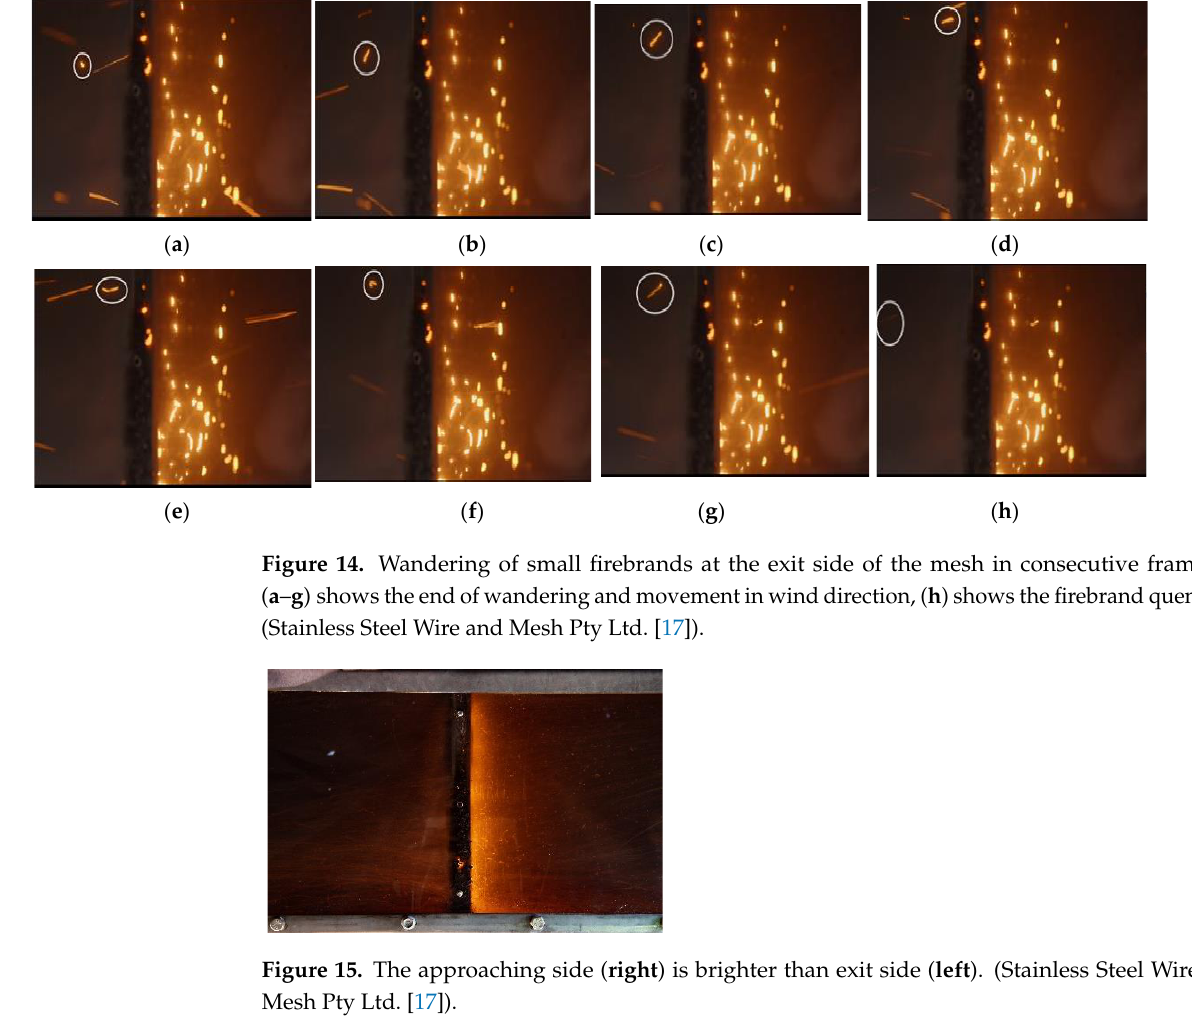
( e ) Figure 17. Firebrands at the exit of the wind tunnel. White, yellow and red circles show quenched, almost quenched and glowing firebrands. All photos taken with a camera set for a shutter speed of 4 milliseconds. The mesh was placed in the test section for ( a – c ) and no mesh was used for ( d , e ). 4.1.4. At the Plastic Sheet The images show the size of the plastic sheet is adequate to be exposed to most firebrands exiting the wind tunnel, both with and without the mesh present. There were considerably fewer glowing firebrands hitting the plastic sheet with the mesh present (see Figure 18). Despite all efforts, the videos show some holes are larger than the area of the burning part of the firebrands due to the slippage of some firebrands on the plastic sheet, the vibration of the plastic sheet and continuation of the burning of the firebrands.